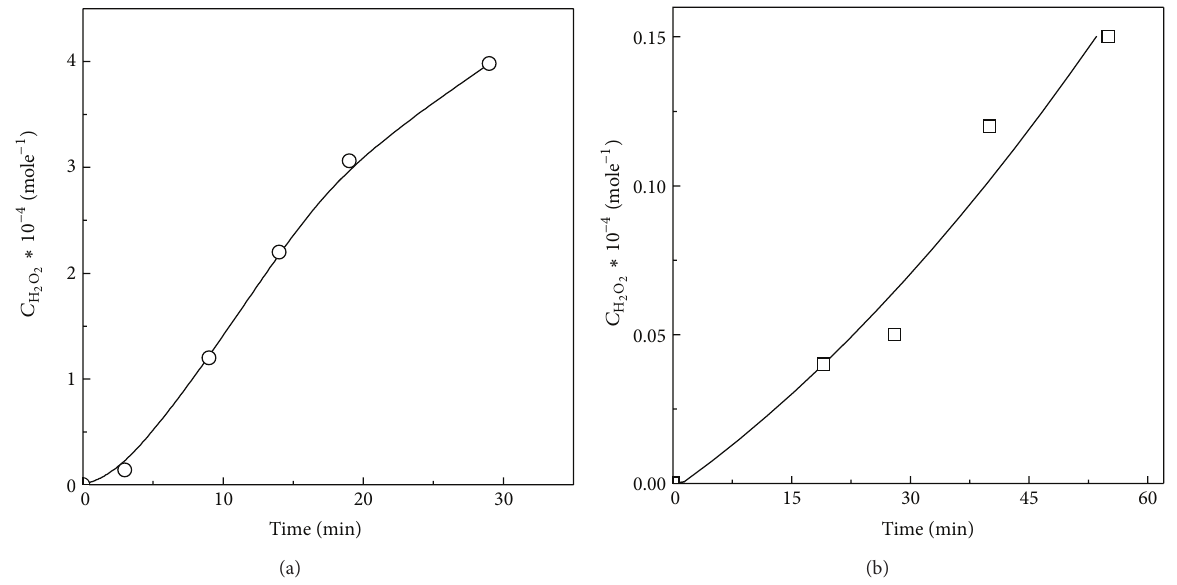
Figure 1: Generation of H 2 O 2 in the photooxidation of tert-butyl alcohol (Co = 1.0 ⋅ 10 −3 M) by Fe +3 ( 1.0 ⋅ 10 −4 mole −1 ) (a), and Cu +2